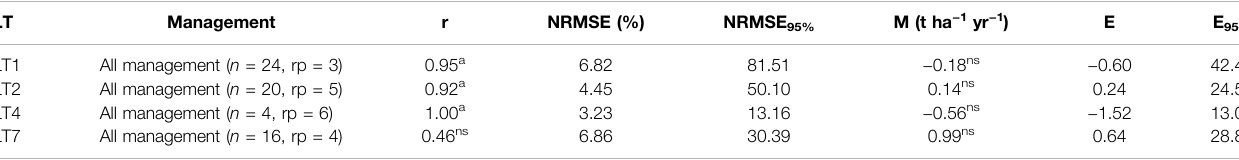
TABLE 3| Statisticsfor theevaluation ofthe performanceofthe ECOSSEmodel onSOCsimulations indiversi fi ed cropping systems intheEuropean agriculture at 0 – 30 cm soil depth. LT Management